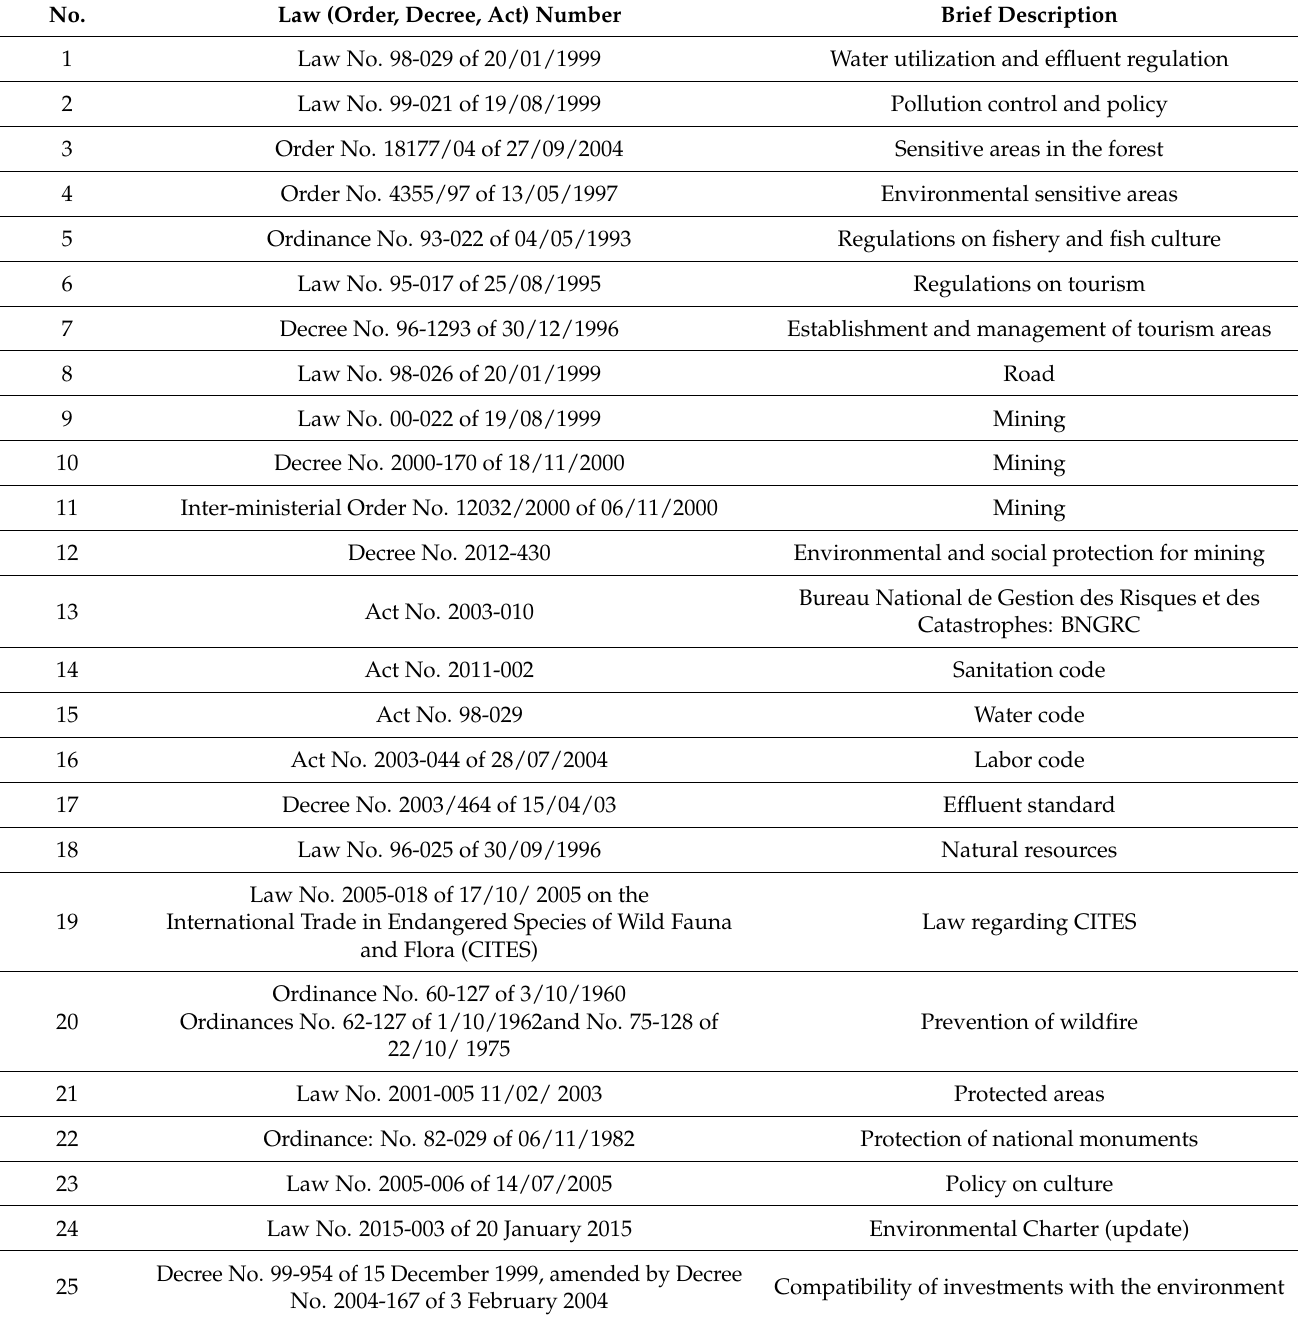
Table 2. Related laws to the environmental considerations in